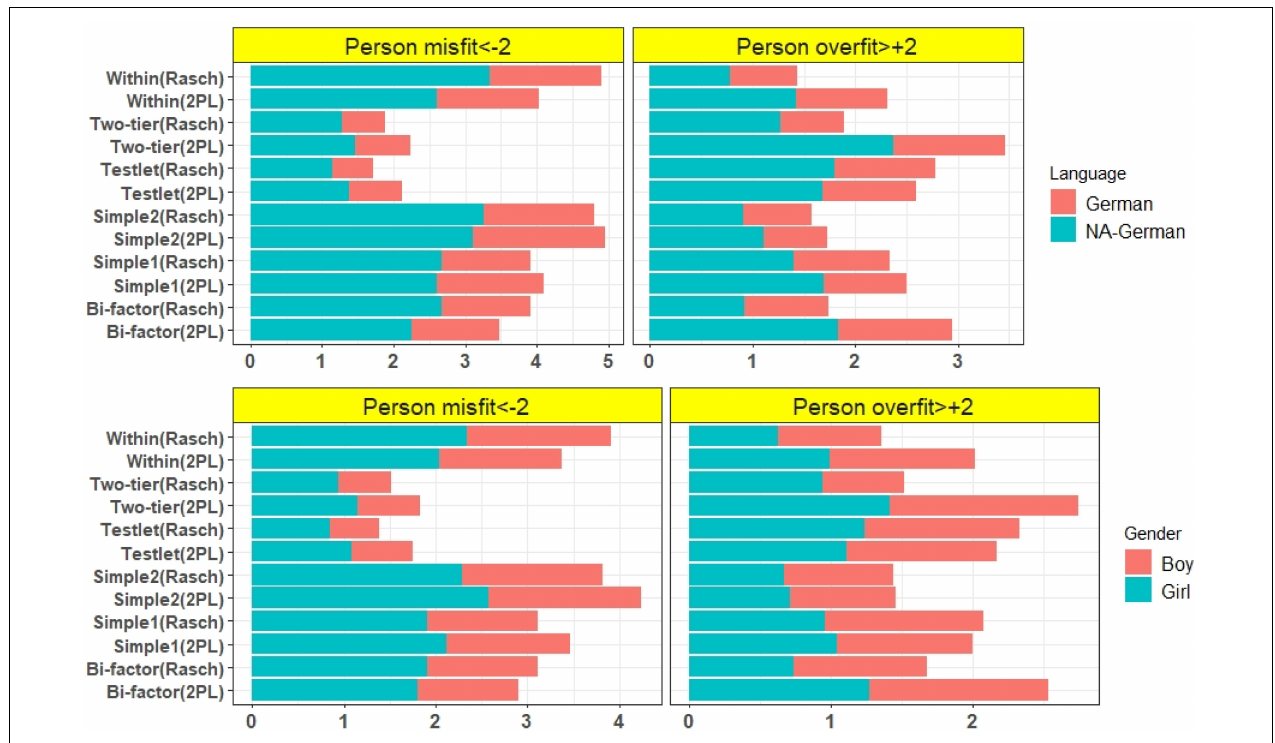
FIGURE 7 | Proportion (%) of the misfit and overfit person of multidimensional models of German Test.